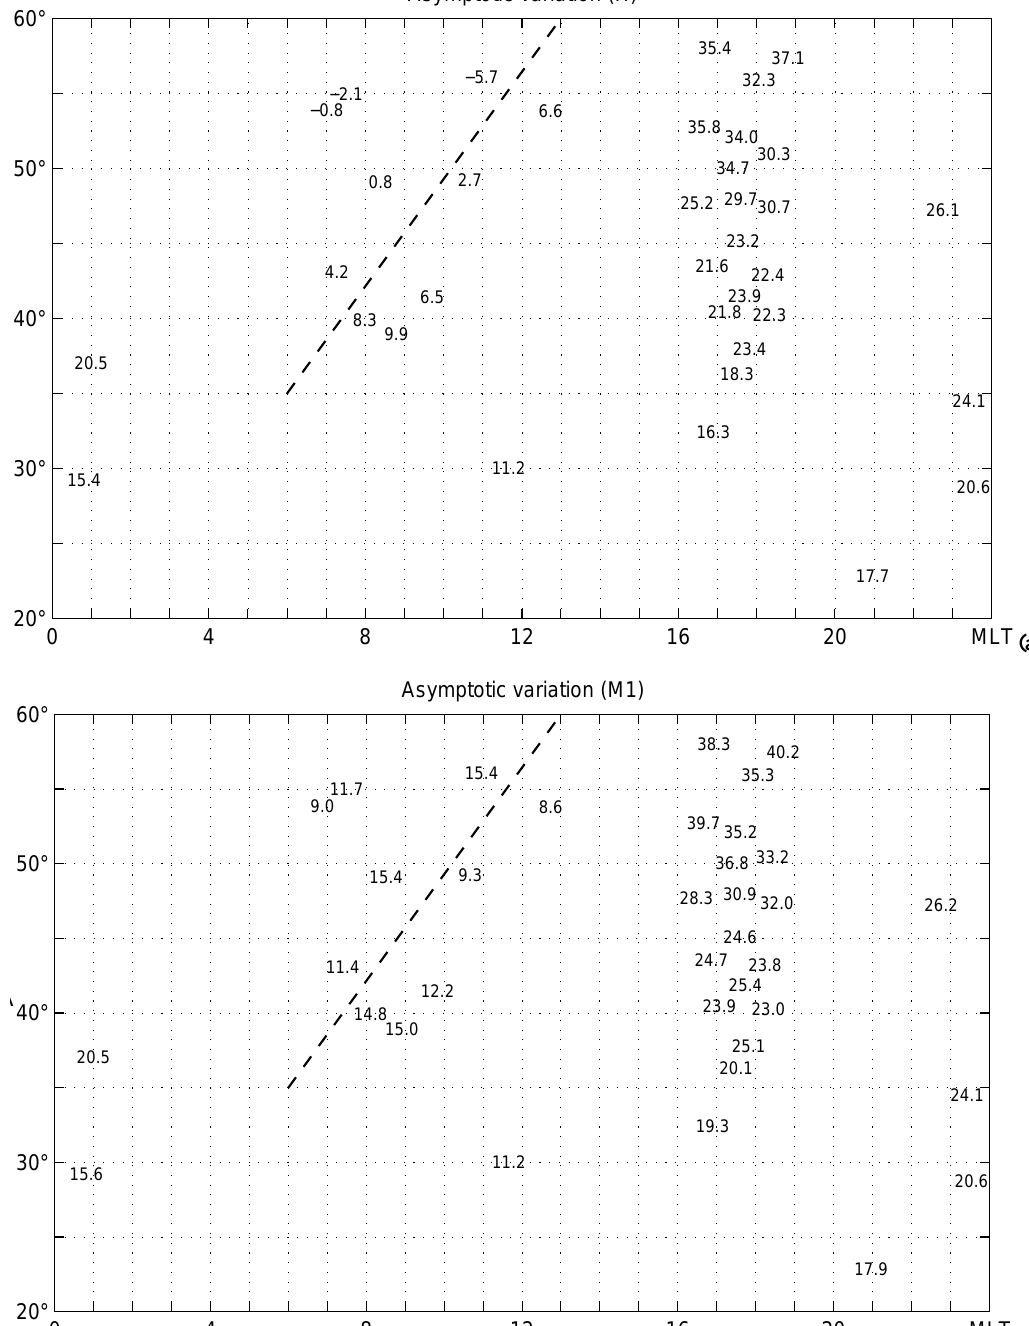
response ( ∼ 21 nT/(nPa) 1 / 2 ) . This aspect suggests that the lowest latitude observations cannot be interpreted in terms of the Chapman-Ferraro current alone. In this case, indeed, the noon response should be larger than the midnight response up to ∼ 45 ◦ (Russell et al.,